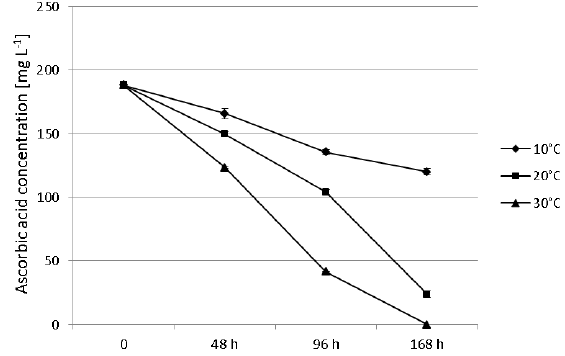
Figure 5: Changes in the concentration of ascorbic acid during storage of multi-fruit juice.